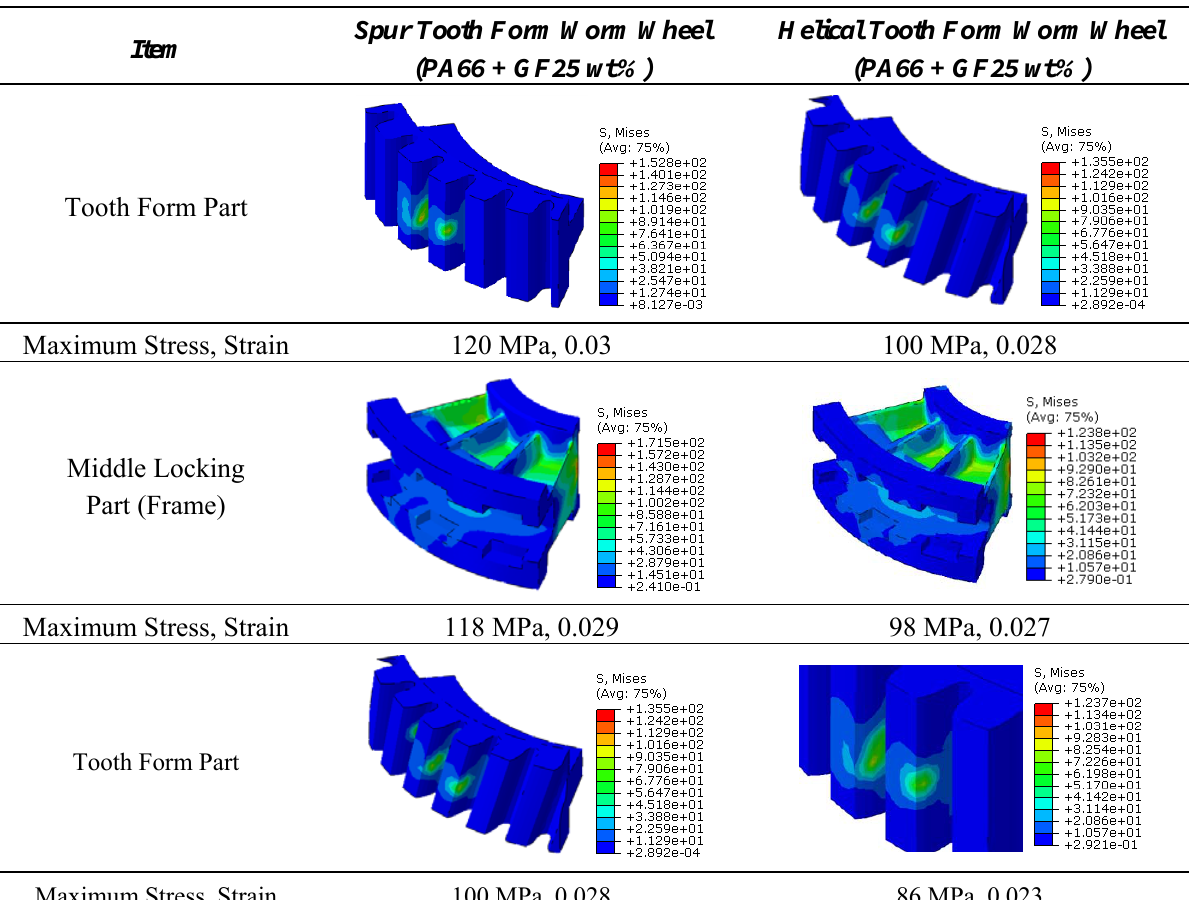
Table 3. Strain-stress comparison analysis of spur vs. helical tooth form worm